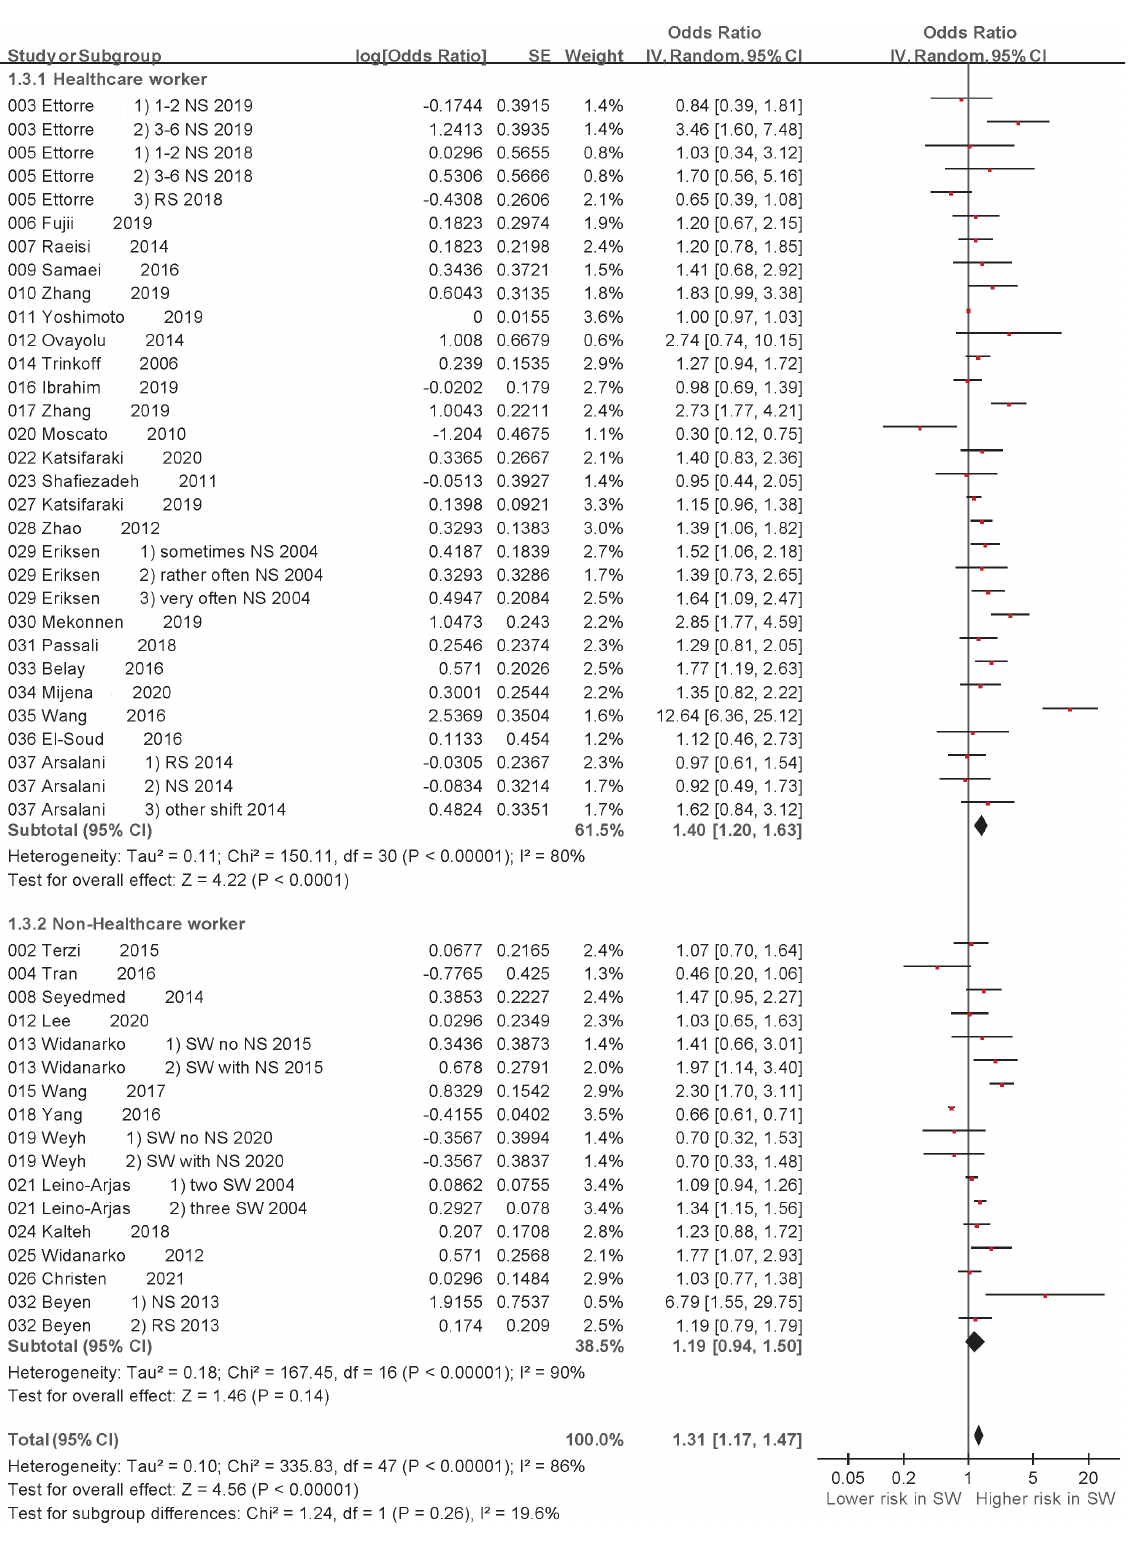
Subgroup analysis of odds ratio of low back pain associated with shift work based on health care worker (HCW) and non-HCW. CI, confidence interval; SE, standard error